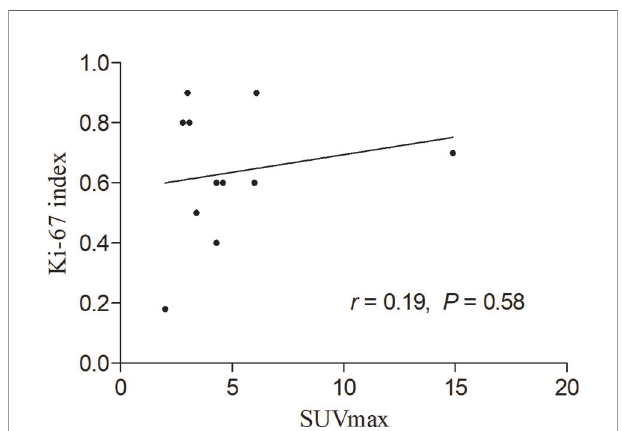
FIGURE 7 | Linear regression analysis showing no signi fi cant correlation between maximum standardized uptake value (SUVmax) in the subcutaneous adipose lesions of the 11 patients with subcutaneous panniculitis-like T-cell lymphoma and proliferation index